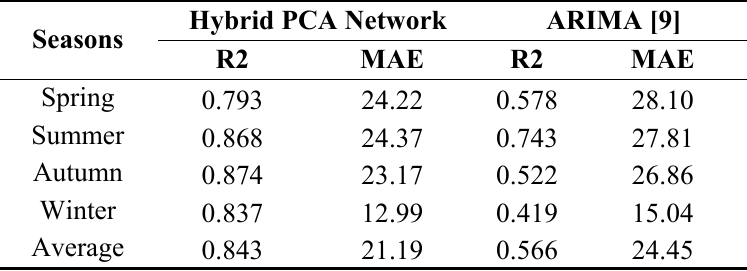
Table 12. Comparison between the proposed hybrid PCA and ARIMA [9]